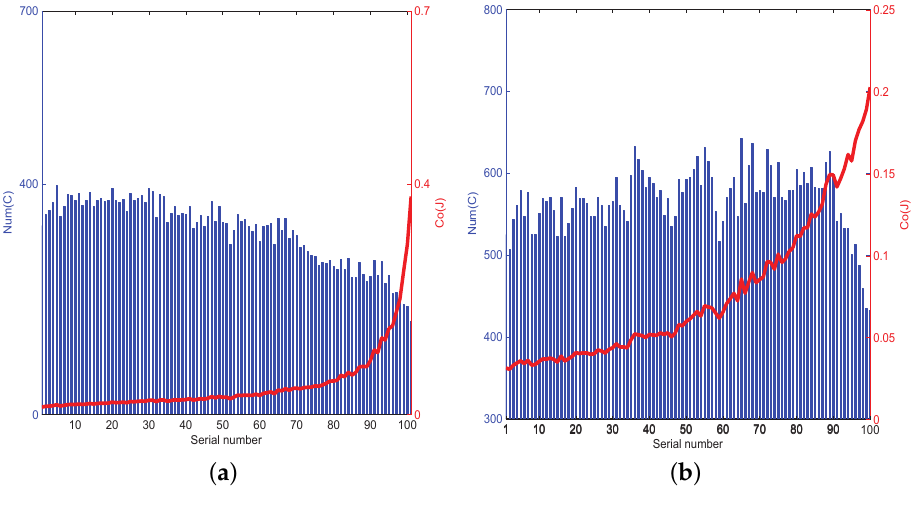
Figure 7. The num ( C ) and Co ( J ) in: ( a ) AC , ( b ) EF .